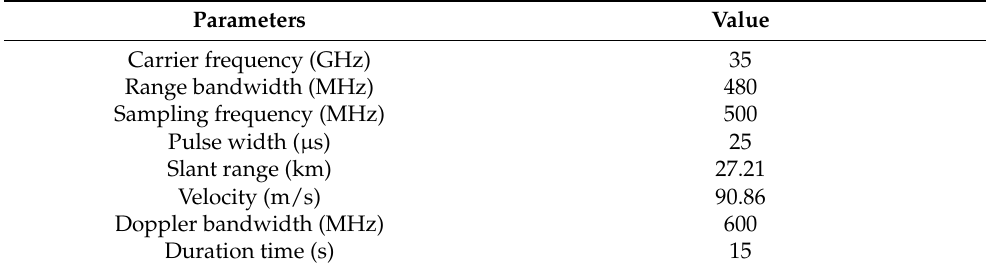
Table 6. System parameters for airborne SAR.